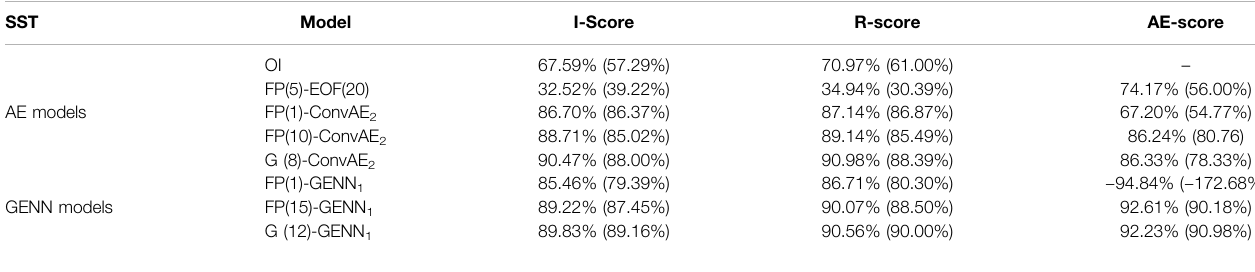
TABLE 2 | Performance on the SST dataset: We evaluate for each model interpolation, reconstruction, and auto-encoding scores, respectively, I-score, R-score, and AE- score, interms ofpercentage ofexplainedvariance, respectively, for theinterpolationofmissingdata areas,the reconstruction ofthewhole fi elds withmissingdata, and the reconstruction of gap-free fi elds. For each model, we evaluate these scores for the training data ( fi rst row) and the test dataset (second row in brackets). In these experiments,weconsideredfourdifferentauto-encodermodels:namely,20-and80-dimensionalEOFsandConvAE 1,2 modelsandtwoGENNmodels.GENN 1,2 ,combined with three interpolation strategies: the classic zero- fi lling strategy (zero), the proposed iterative fi xed-point (FP) and gradient-based (G) schemes, the fi gure in brackets denoting the number of iterations. For instance, FP(10)-GENN 1 refers to GENN 1 with a 10-step fi xed-point interpolation scheme. The EOFs are trained from gap-free data. We also consider an OI scheme with a space – time Gaussian covariance with empirically tuned parameters. We refer the reader to the main text for the detailed parameterization of the considered models. Here, we report, for each auto-encoder type, the best con fi guration in terms of the interpolation score. The detailed results are reported in Supplementary Appendix .